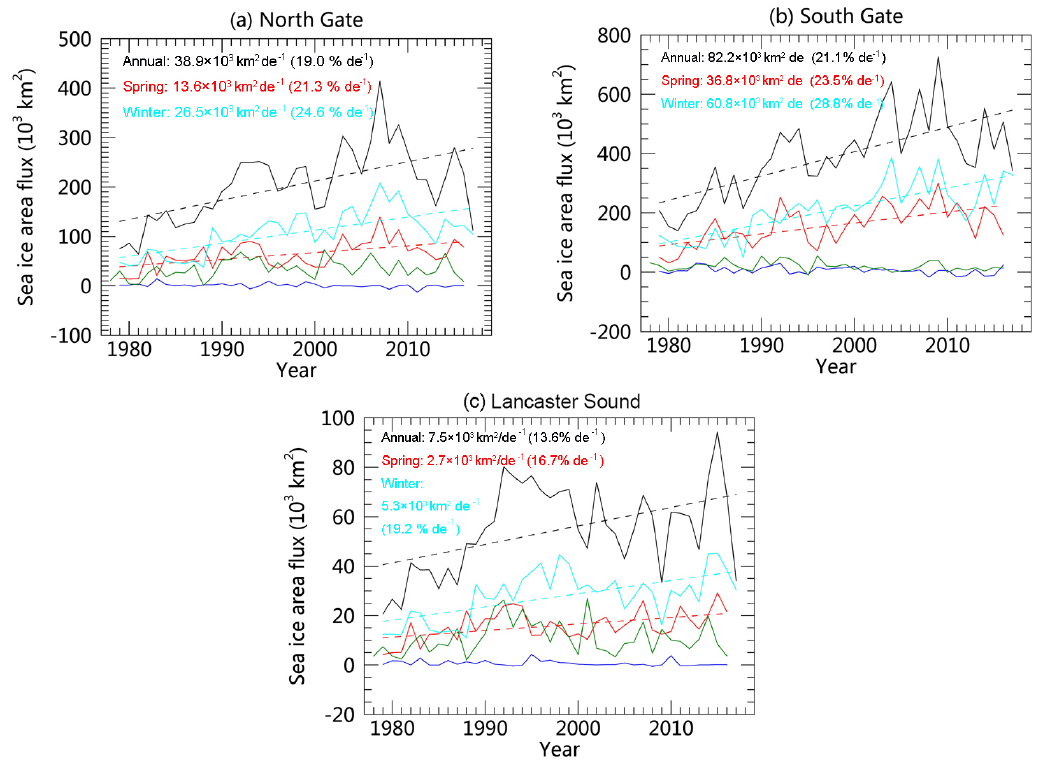
Figure 12. Time series of annual (September–August) sea ice area flux (thick black line) across (a) the northern gate, (b) the southern gate, and (c) Lancaster Sound. Seasonal flux is estimated for winter (December–February, cyan line), spring (March–May, red line), summer (June–August, green line), and autumn (September–November, blue line). The dashed lines represent the linearly fitted trends. The annual and cold-season (winter and spring) trends are all significant at the 99% level. However, for the warm seasons (summer and autumn), the trends are not statistically significant and are not shown in the panels.